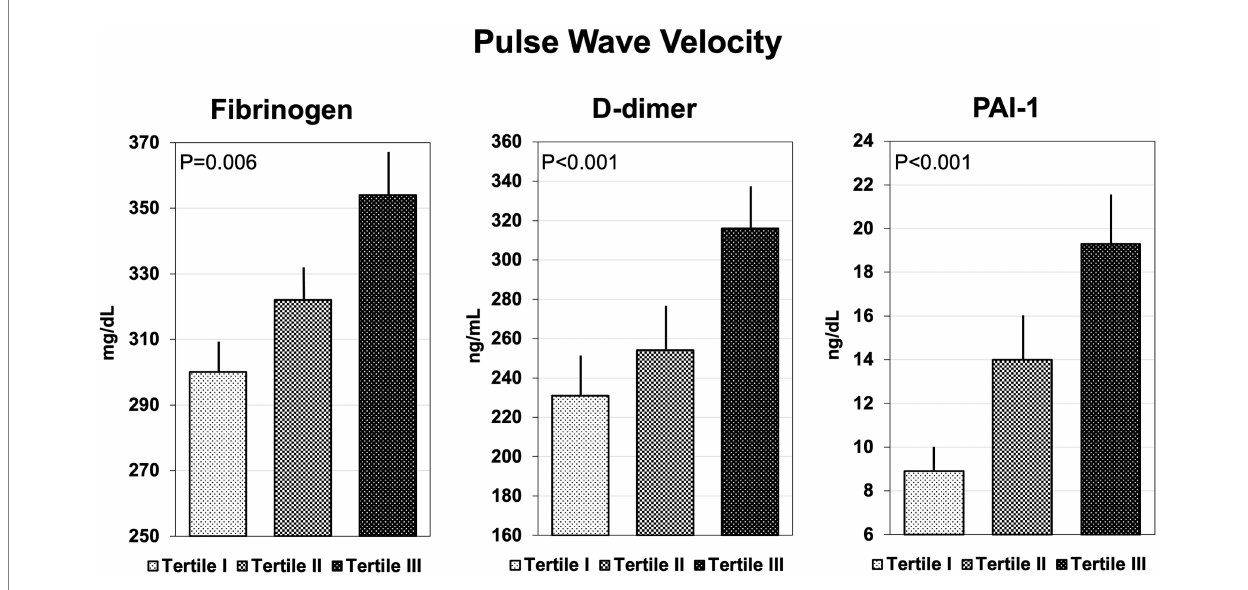
FIGURE 2 Bar graph showing the plasma concentrations of fibrinogen, D-dimer, and plasminogen-activator inhibitor-1 (PAI-1), across tertiles of pulse wave